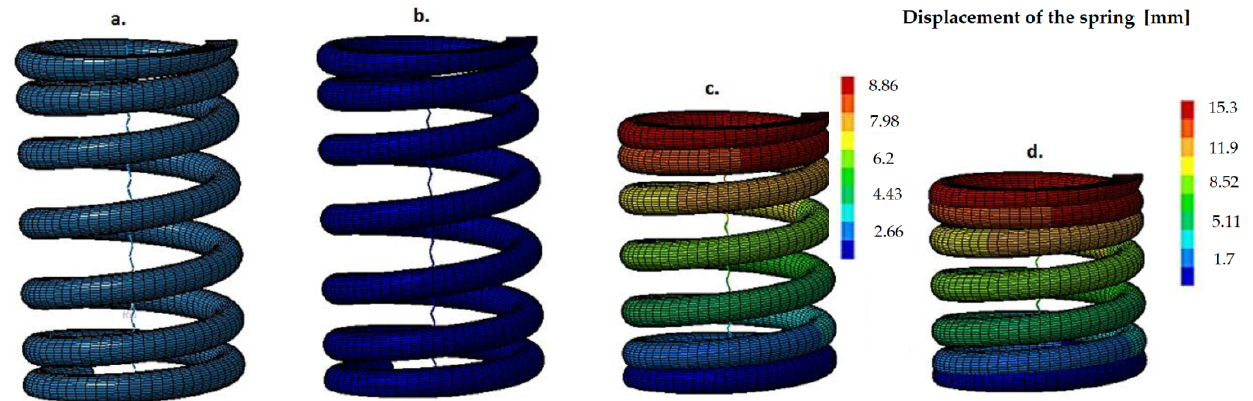
Figure 9. Spring of the valve: ( a ) defined in PDS, ( b ) free state, ( c ) prestressed, ( d ) stressed for maximum valve